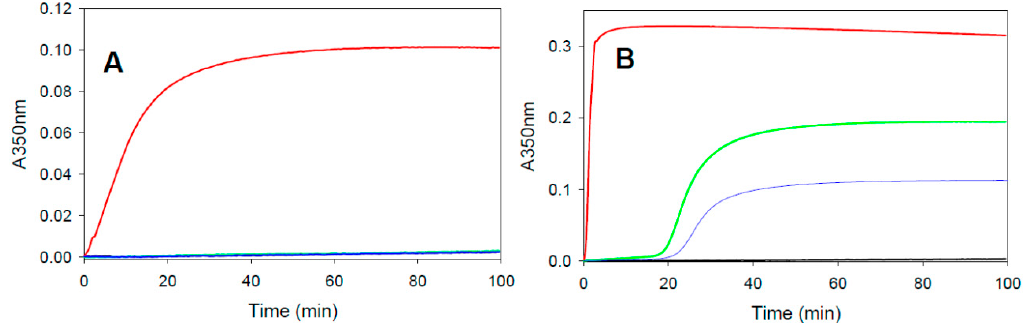
Figure 5. Time course of assembly of 25 µ M tubulin in 10 mM sodium phosphate, 1 mM ethylene diamine tetraacetic acid (EDTA), 1 mM GTP, pH 7.0 supplemented with either ( A ) 3 mM or ( B ) 7 mM MgCl 2 , final pH 6.7 in the presence of 27.5 µ M zampanolide (red line), taccalonolide AJ (green line), cyclostreptin (blue line) or dimethylsulfoxide (DMSO) (vehicle, black line).